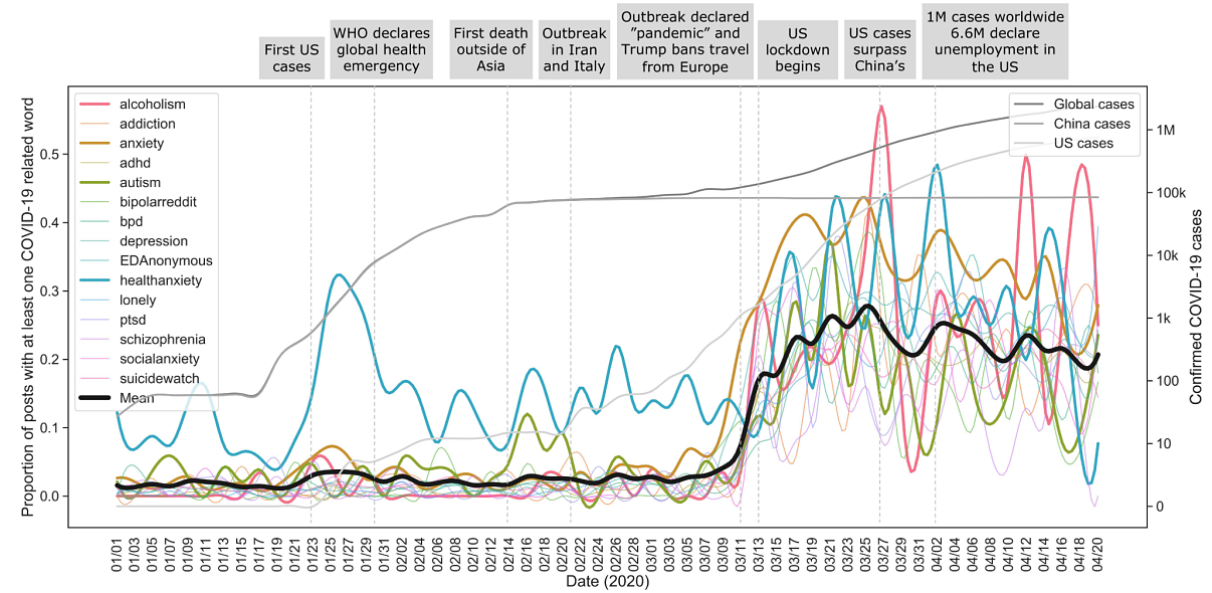
Figure 1. Mention of COVID-19–related words across mental health support groups. Timeline landmarks were chosen from NBC News timeline given that US users are the most prevalent across Reddit. Global, China, and US confirmed COVID-19 cases are displayed. The overall acute rise in COVID-19–related words occurs on March 11, 2020. The correlation between the mean proportion of COVID-19–related posts and global COVID-19 cases is ρ =0.83 ( P <.001). The health anxiety subreddit has a large increase in COVID-19–related posts almost 2 months before the general increase. r/alcoholism has the most amount of posts related to COVID-19 on March 27. adhd: attention-deficit/hyperactivity disorder; bpd: borderline personality disorder; EDAnonymous: Eating Disorders Anonymous; ptsd: posttraumatic stress disorder; WHO: World Health